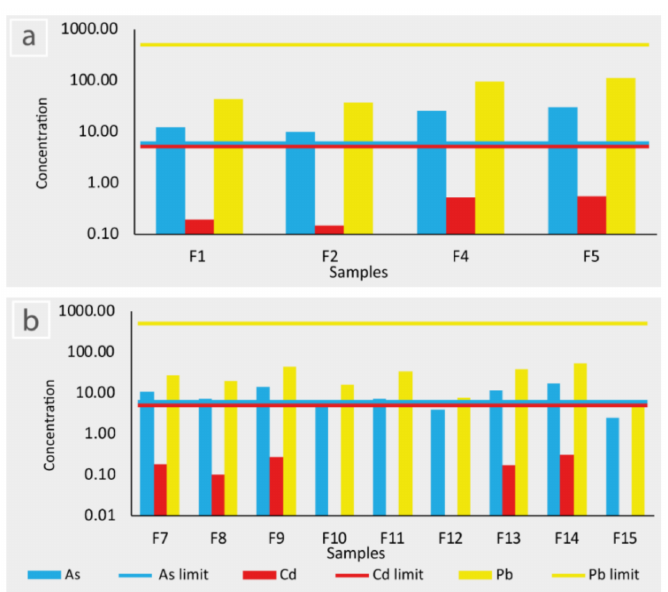
Figure 6. Comparison of As, Cd, and Pb concentrations with their legal limits: ( a ) first and ( b ) sec- ond campaign.